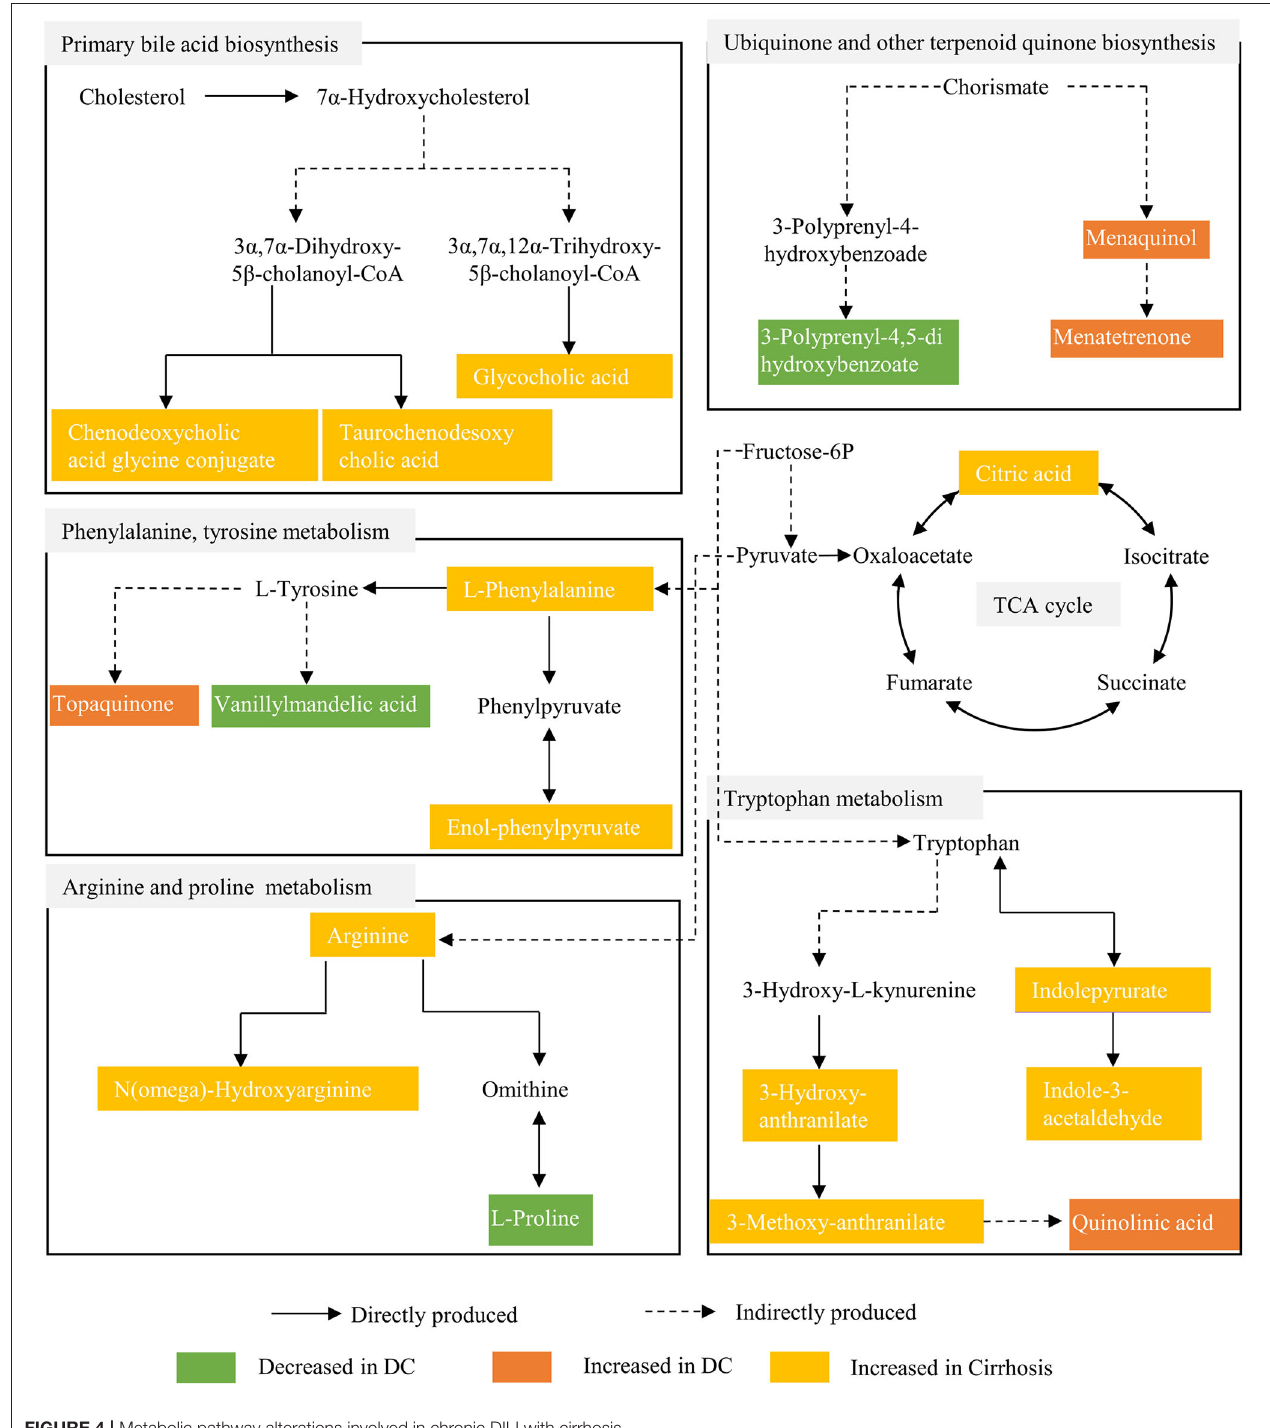
FIGURE 4 | Metabolic pathway alterations involved in chronic DILI with cirrhosis.